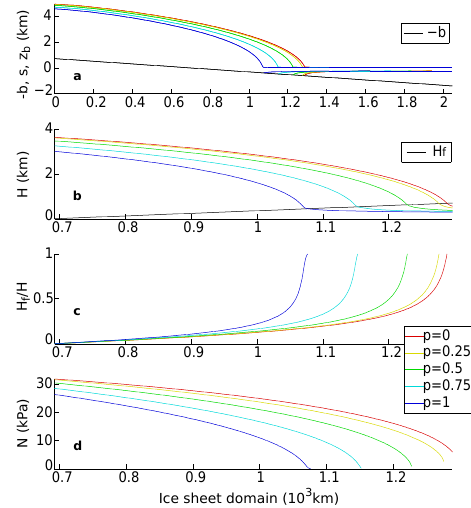
Figure 1. Dependence of ice geometry and effective pressure on the parameter p over a linear bed as in Schoof (2007b). All pan- els show the fixed-grid solution at 0.8km resolution without a grounding-line parameterization (see Sec. 2.3) and with ice soft- ness A = 10 − 25 Pa − 3 s − 1 . (a) Ice surface and bedrock (colors), and basal elevation (black) over the full ice-sheet domain. (b) Ice sheet thickness (colors) and flotation thickness (black) over the marine portion of the ice sheet. (c) The ratio between the flotation thickness and the ice-sheet thickness. (d) The effective pressure N , which ap- proaches zero more smoothly with increasing p . Plots in panels (c) and (d) include only grounded cells, as the ice is exactly at flotation and effective pressure is zero elsewhere. The plotted effective pres- sure does not go to zero for all p > 0 because the grounding line lies between the last grounded cell and the first floating cell.